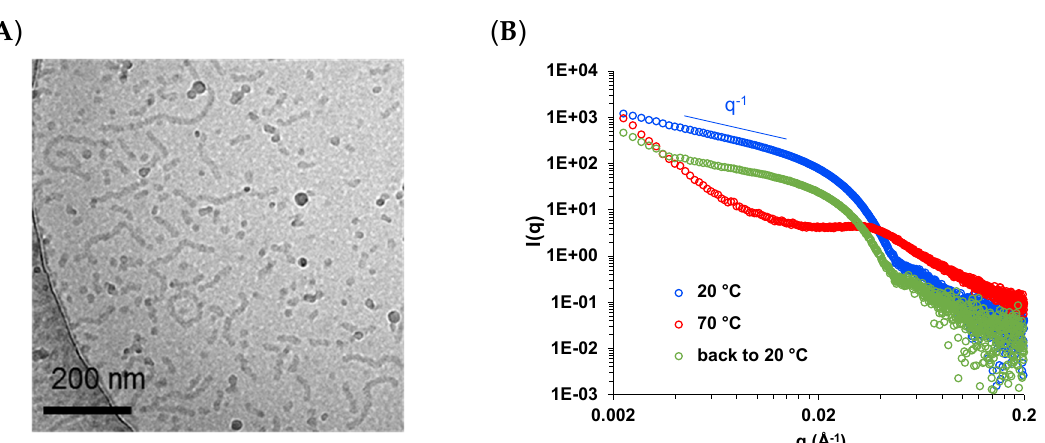
Figure 7. PDMAm 23 - b -PCMAm 93 ( sample 3 ) aqueous dispersions: ( A ) Representative cryo-TEM image prepared at room temperature at 1 wt%; ( B ) SAXS profile at 1 wt% at 20 °C (in blue), 70 °C (in red) and back to 20 °C (in green).